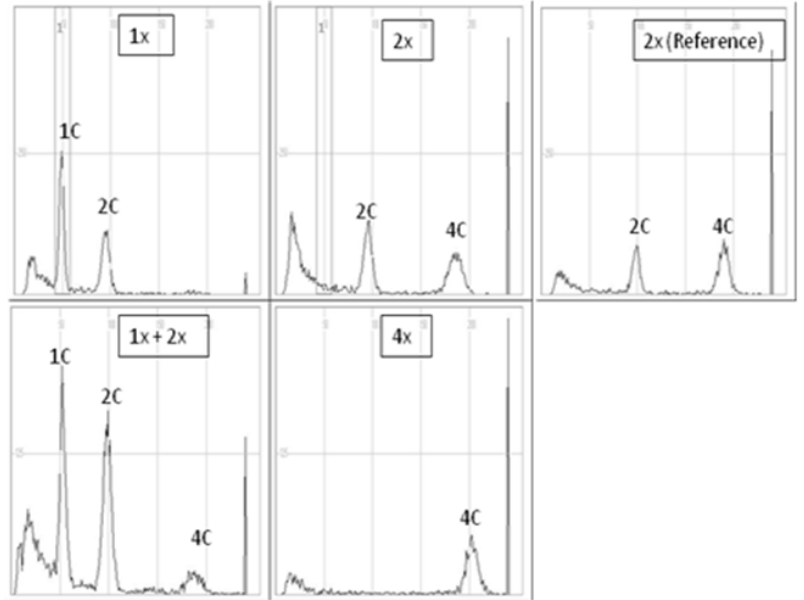
Figure 2. Sample histograms of cytometric analysis of haploid (1x), diploid (2x), mixoploid plants